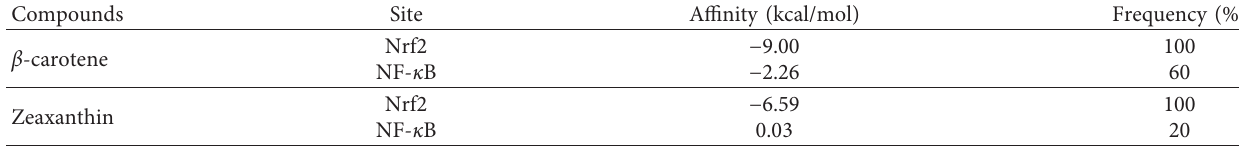
Table 1: Docking of β -carotene and zeaxanthin on active sites of different target proteins.